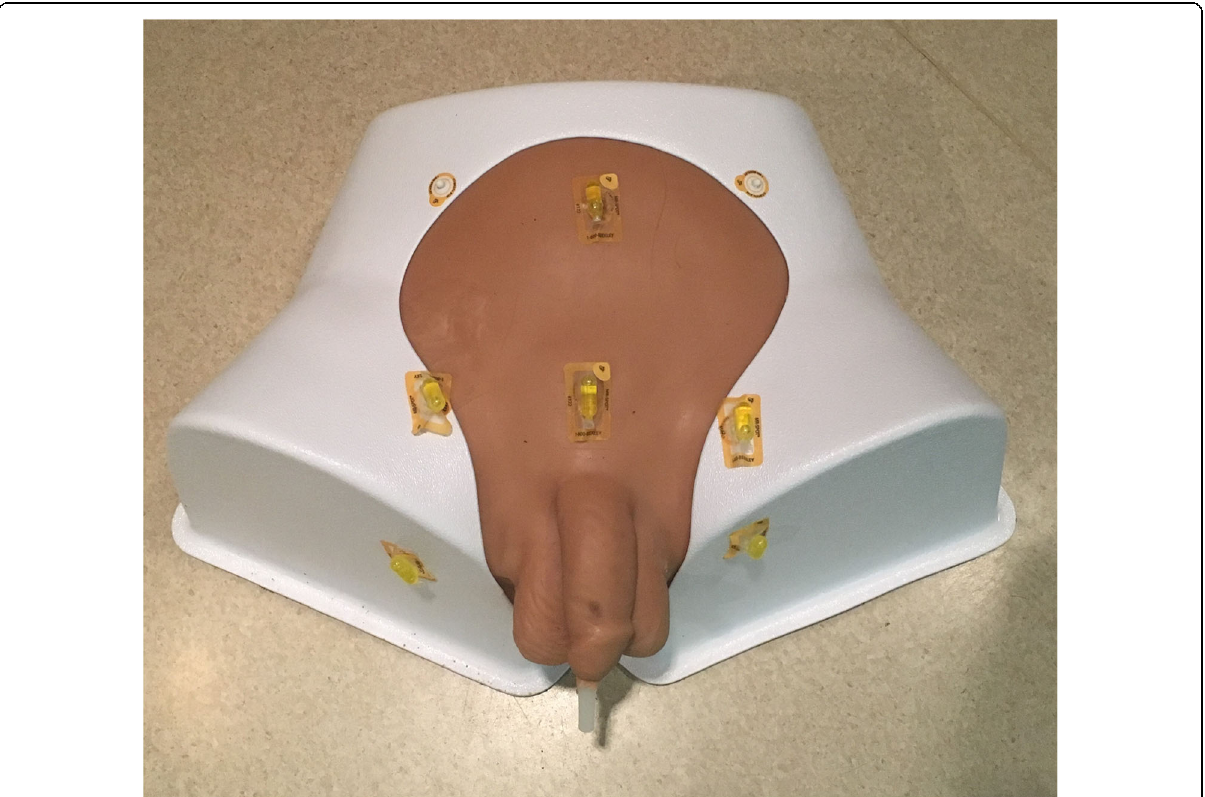
Fig. 3 Custom phantom model. This experiment was performed on a custom pelvic anthropomorphic phantom model. The model contains a catheterisable urethra and urinary bladder, prostate, and surrounding prostatic structures oriented anatomically and visualised on magnetic resonance imaging (MRI), computed tomography (CT), and ultrasound. CT and MRI fiducial markers, which measured simulated motion, are visible on the model